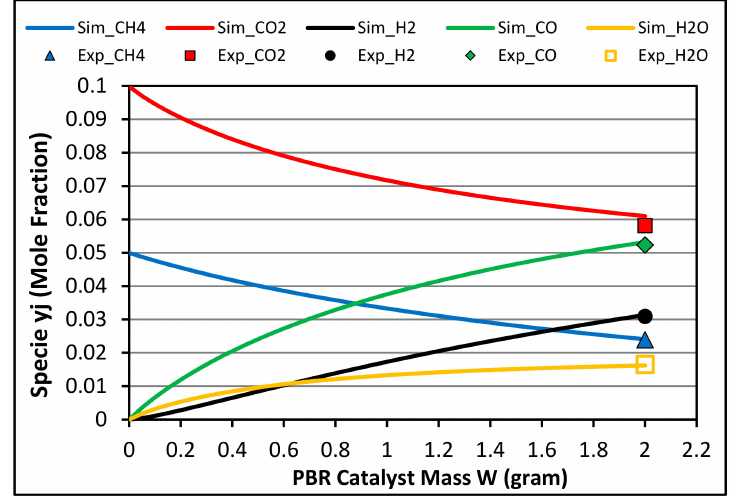
Figure 5. Experimental outlet data, and global model-simulated species PBR profiles: T = 923 K, feed CH 4 / CO 2 = 0.5, gas space velocity (GSV) = 5.56 × 10 − 4 m 3 / s-kg. “Sim” = model-simulated, “Exp” =